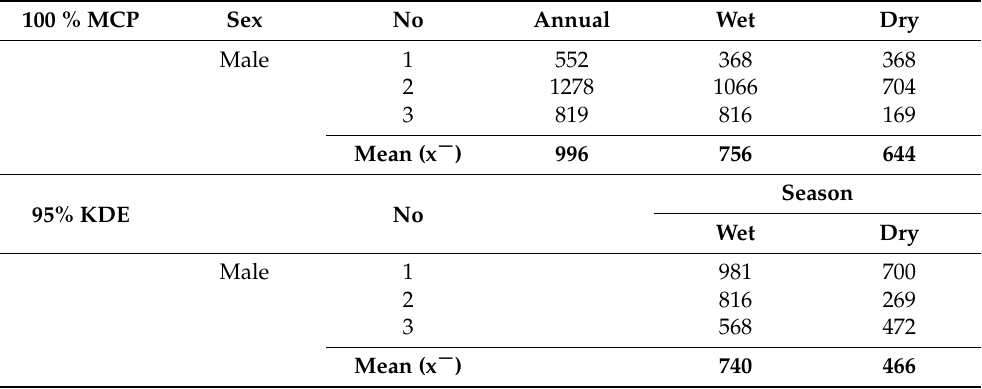
Figure A3. Spatial distribution of one collared elephant with the ID GSM2014-1615 ( n = 17,472) in the Amboseli National Park in Kenya, covering the Kilimanjaro National Park and Enduimet Wildlife Management Area (EWMA) in Tanzania. Source: Amboseli Trust for Elephants. Table A3. Annual and seasonal 100% maximum convex polygon (100% MCP), and Seasonal 95% Fixed kernel density (KDE) home range sizes (km 2 ) for three male elephants monitored via GPS collars in Amboseli, Kenya, and in northern Tanzania from (2019–2020). Wet = wet season (January–May; dry = dry season